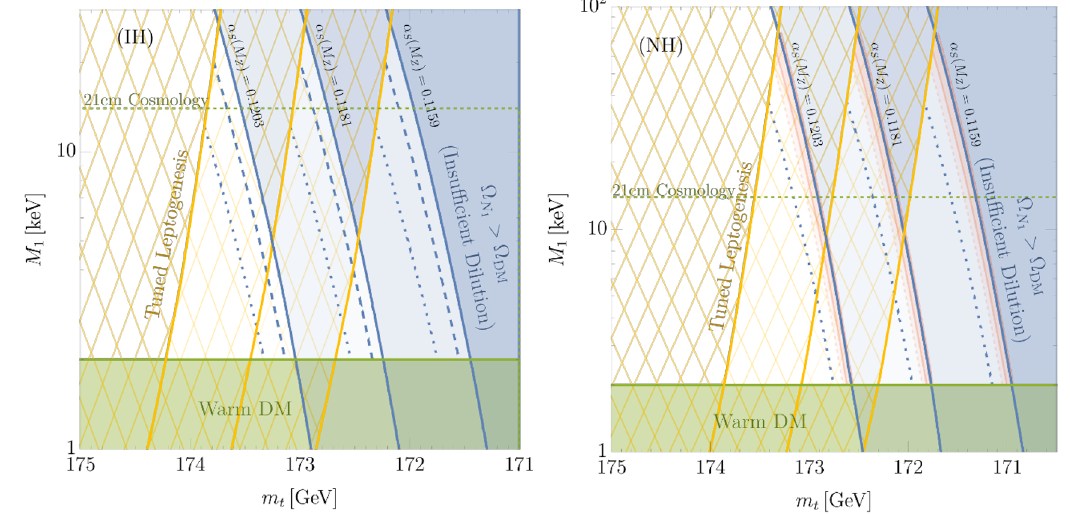
Figure 16 . The parameter space of N 1 DM from freeze-out, natural leptogenesis, and consistent neutrino masses in terms of the mass of N 1 , M 1 , and the mass of the top quark, m t . Remarkably, N 1 DM, natural leptogenesis, and the observed neutrino masses are consistent with the current measurement of m t = 173 . 0 ± 0 . 4 GeV . The center triangle fixes α S ( M Z ) at its central value, and the triangles to the left and right at ± 2 σ values. We fix m h at its central value throughout, since variations in m h within its uncertainty do not appreciably change the parameter space. The ν 2 and ν 3 masses are fixed by: Left the Inverted Hierarchy (IH) in accordance with the top left panel of figure 14 and Right by the Normal Hierarchy (NH), in accordance with the bottom right panel of figure